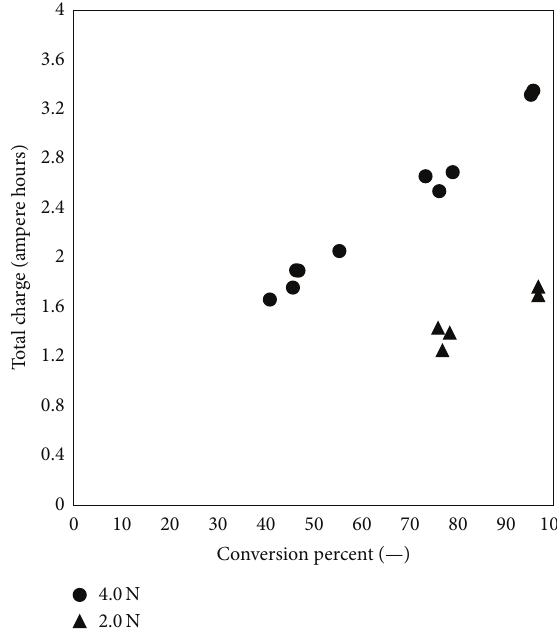
Figure 2: Conversion percent (—) versus total charge (ampere